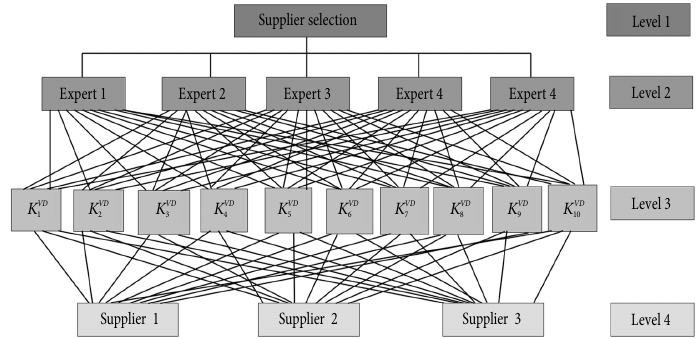
Fig. 2. Application of AHP method in this example – supplier